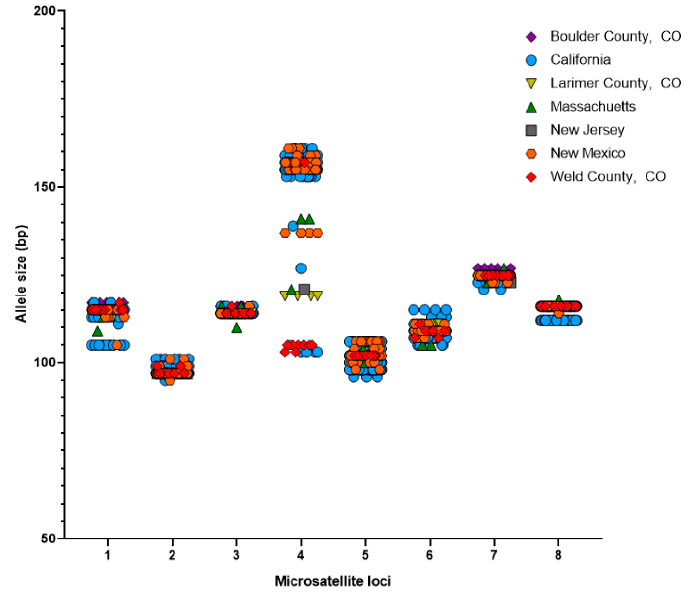
Figure 2. Microsatellite locus allelic diversity varies among Microsporum canis isolates. Allele sizes for microsatellite loci (MS) 1–8 for each sample are plotted with Boulder County, CO ( n = 6); Cali- fornia ( n = 122); Larimer County, CO ( n = 4); Massachusetts ( n = 5); New Jersey ( n = 1); New Mexico